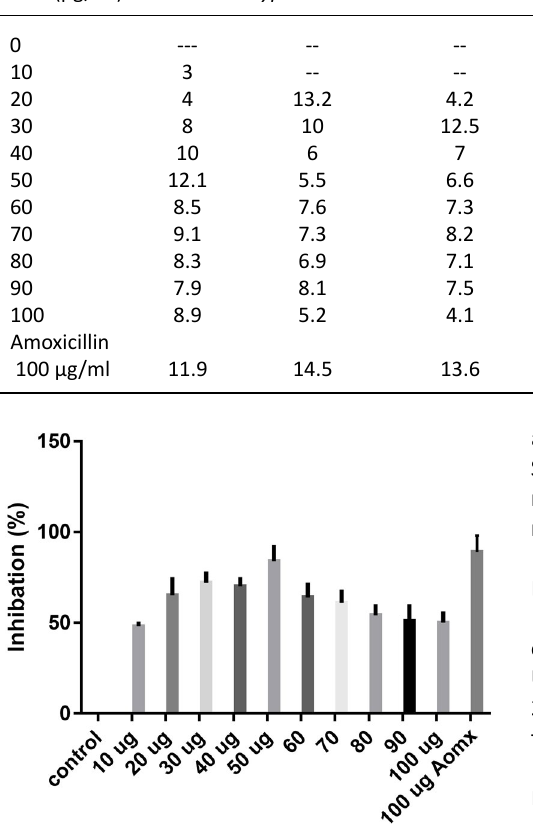
Table 2. Inhibation activity of TIT3 at different concentration (mm)